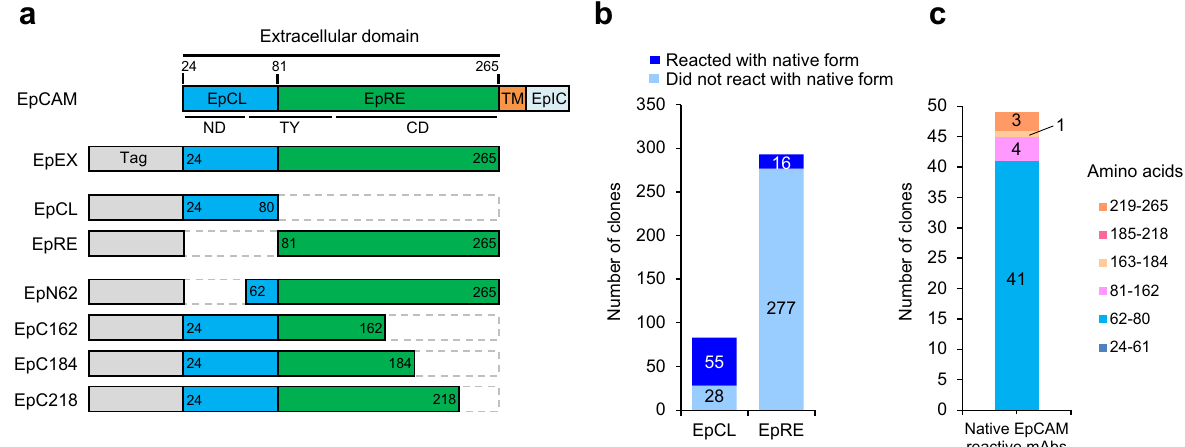
Figure 1. Production of anti-epithelial adhesion molecule (EpCAM) monoclonal antibodies (mAbs) in transchromosomic (TC-mAb) mice. ( a ) Schematics of partially fragmented EpCAM proteins. The EpCL region, illustrated in blue, contains the N-terminal domain (ND) and a part of the thyroglobulin type-1 domain (TY), whereas the EpRE region, illustrated in green, contains parts of TY and the cysteine-poor region (CD). All EpCAM protein fragments used in this study lack TM and EpIC regions. Truncated fragments are shown as dotted gray lines. The numbers in the box indicate the amino acid number to be translated at the start or end of the truncated protein. ( b ) Quantitative comparison of the mAbs and their binding regions. The numbers of mAbs that were reactive with the EpCAM native form (blue), as well as mAbs that were ELISA-positive but non-reactive with the EpCAM native form (sky blue), are indicated. Reactivity of the native form of EpCAM was determined by immunocytochemistry. ( c ) Summary of epitope mapping by western blotting. The epitope distribution of the mAbs against the EpCAM native form is